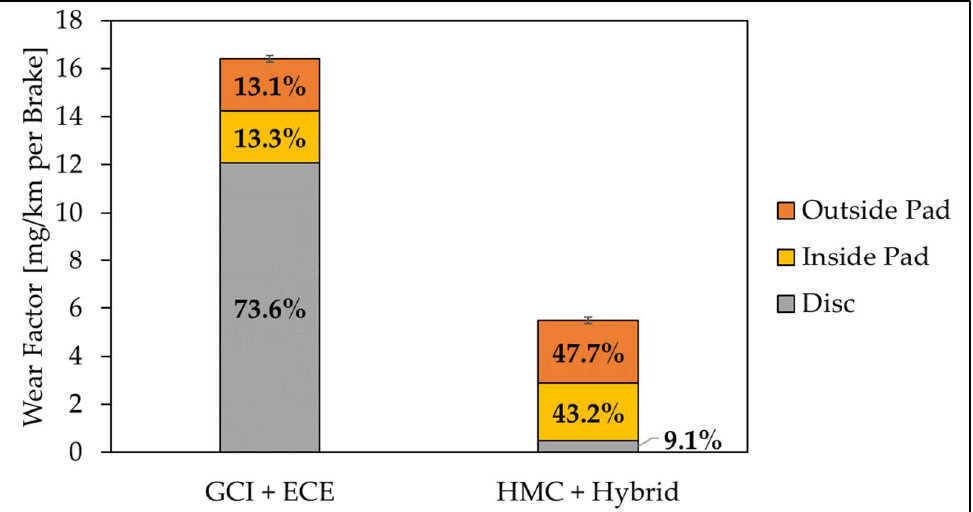
Figure 13. Wear factors of the HMC pairing compared to the GCI pairing after 8× WLTP Brake Cycle. HMB friction pairing with specially adapted hybrid lining.